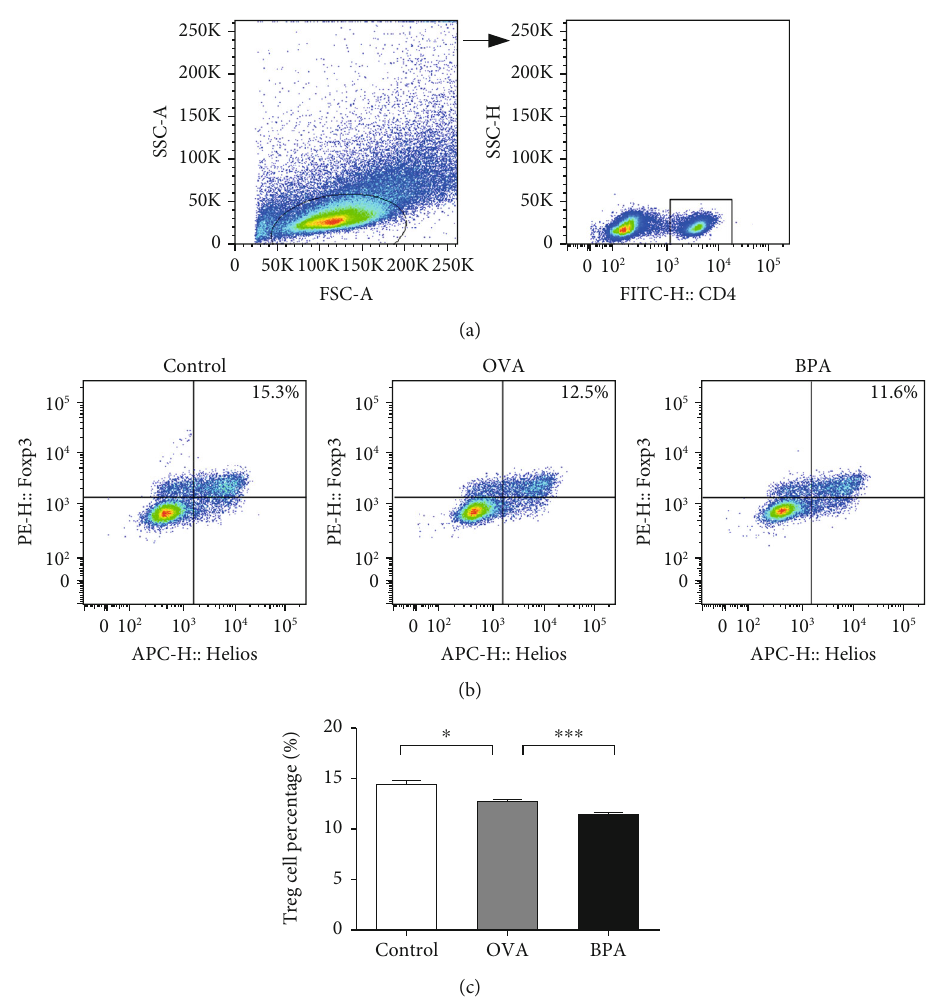
Figure 7: Flow cytometry showed that BPA reduced the proportion of Tregs in spleens of mice with OVA-induced AR. CD4 + T cells (a). Representative staining of CD4 + Helios + Foxp3 + Tregs from each group. The numbers in the upper right quadrants are the proportions of Tregs (b). The statistical data (c). Data are expressed as means ± SEM ; n = 5 per group. ∗ P < 0 : 05 ; ∗∗∗ P < 0 : 001